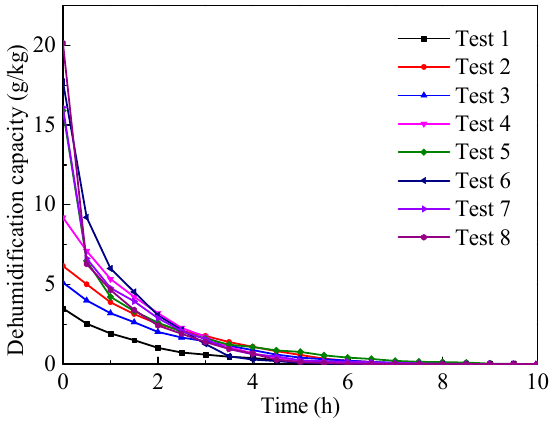
Figure 7. Variation of the dehumidification capacity with time.